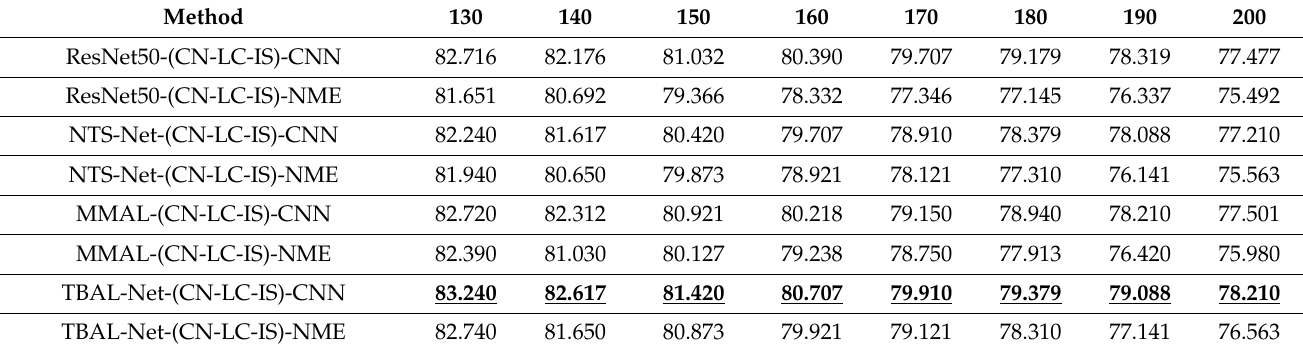
Table 6. Performance (Top-1 Accuracy %) on CUB-200-2011 as the number of classes increases from 130 to 200. Method